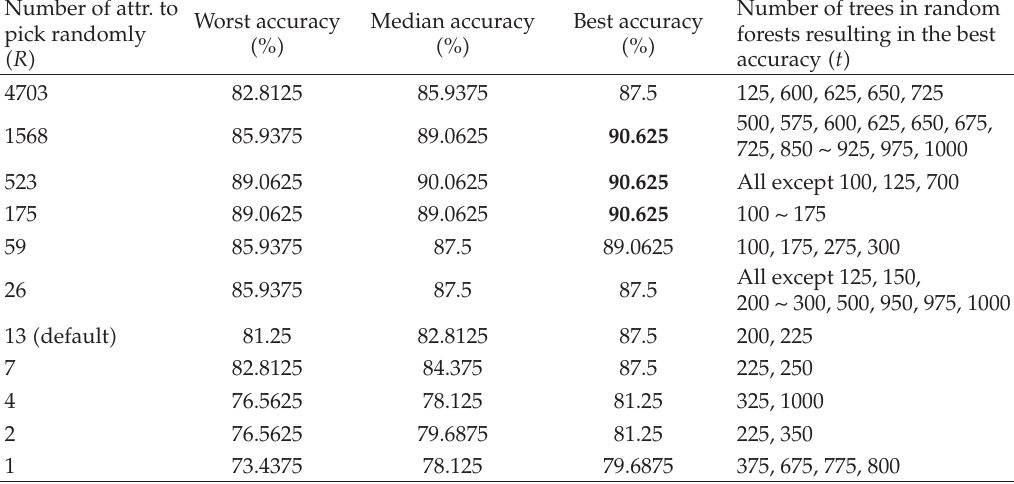
Table 16: The accuracy of random forests for the data set “DB world.”